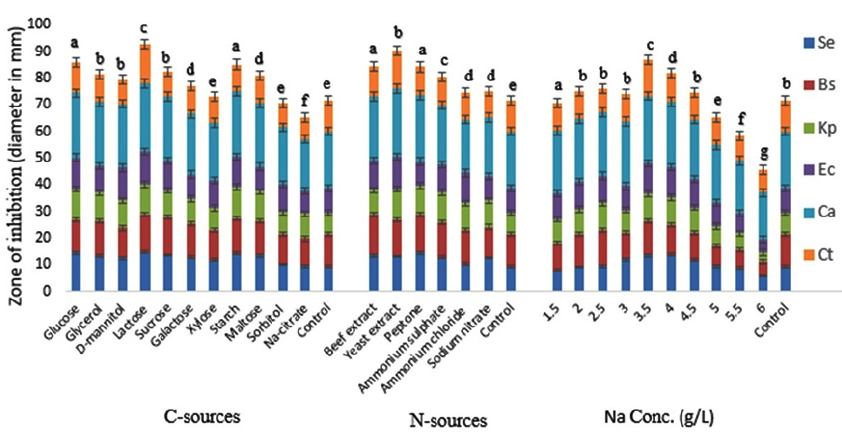
Fig. 2. Effect of different C-source, N-sources and NaCl concentration on the bioactive metabolite production by G. pallida (KU693285) against test microbes. Se= S. epidermidis, Bs =B. subtilis, Kp = K. pneumoniae, Ec =E. coli, Ca =C. albicans, Ct = C. tropicalis. Vertical bars represent standard deviation (±SD, n=3). Means with different letters within an assay were significantly different (p <